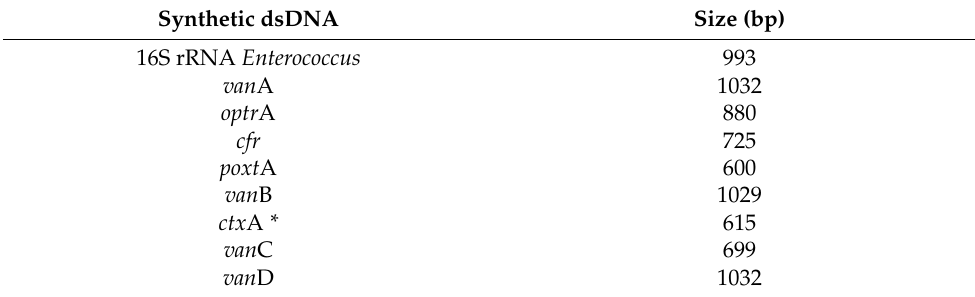
Table 3. Synthetic DNA utilized as positive and internal amplification control. Synthetic